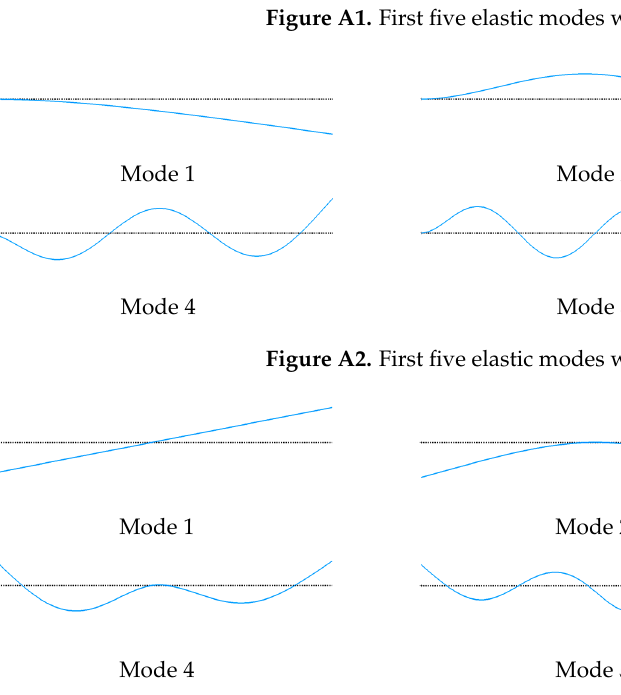
= . Figure A3. Rigid-body mode and first five elastic modes with BC3: y ( L /2 ) = 0.